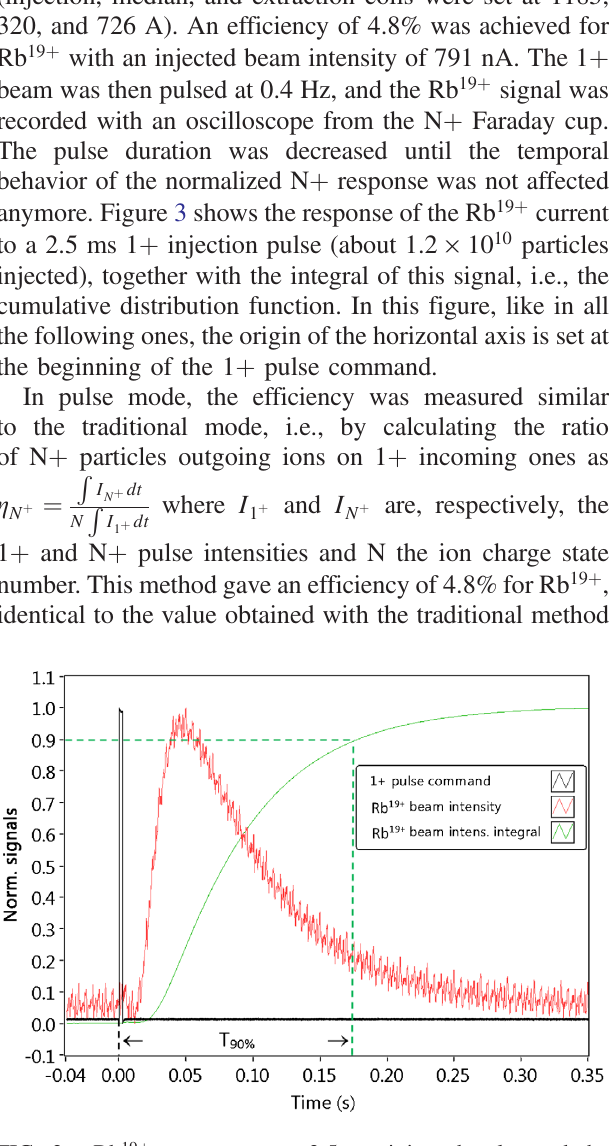
FIG. 3. Rb 19 þ response to a 2.5 ms injected pulse and the corresponding integral function. Dashed lines are the references of the pulse start (black) and 90% level of the Rb 19 þ integral function